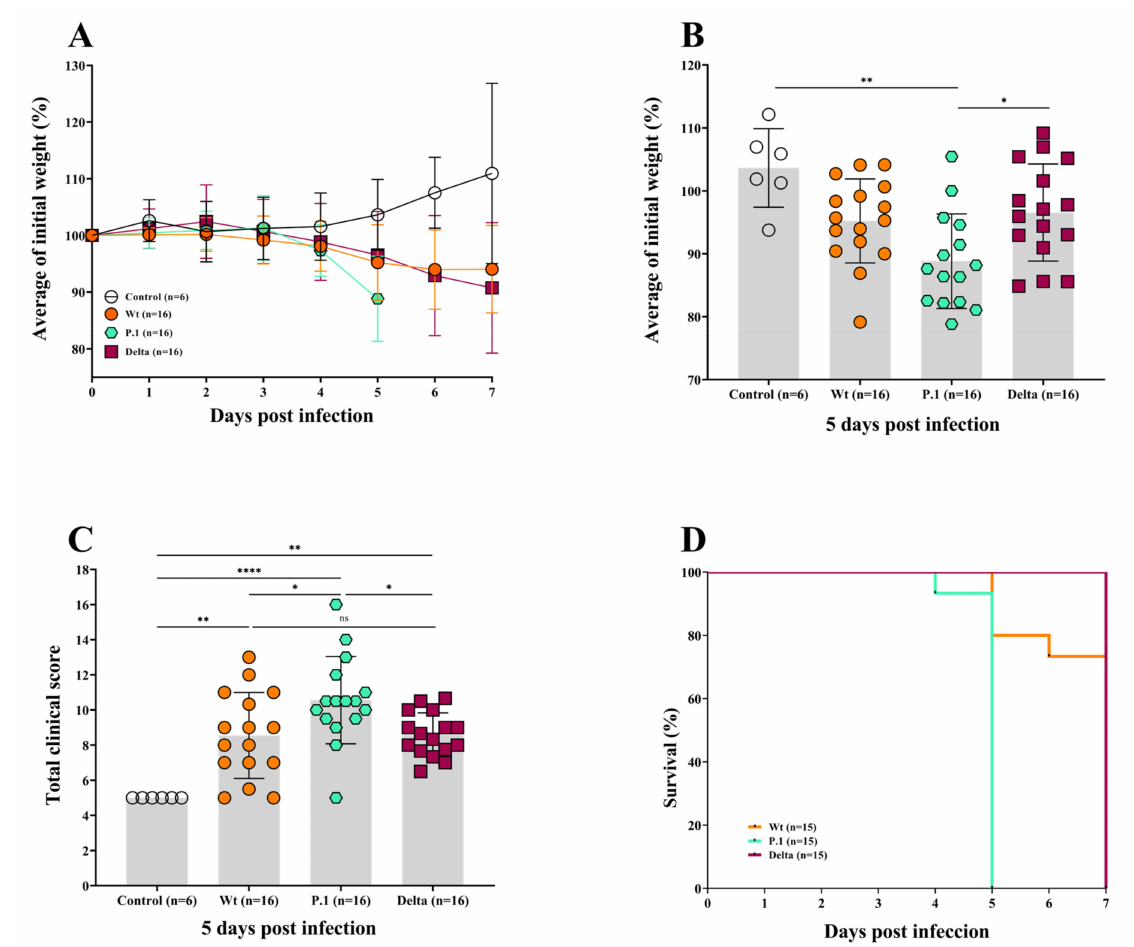
Figure 1. The P.1 variant induced a greater weight loss and clinical manifestation than the Delta variant and Wt strain in ACE2-transgenic mice. ( A , B ) The average of weight loss of K18-hACE2 transgenic mice infected intranasally with 10 5 PFU of the Wt strain and the P.1 and Delta variants.